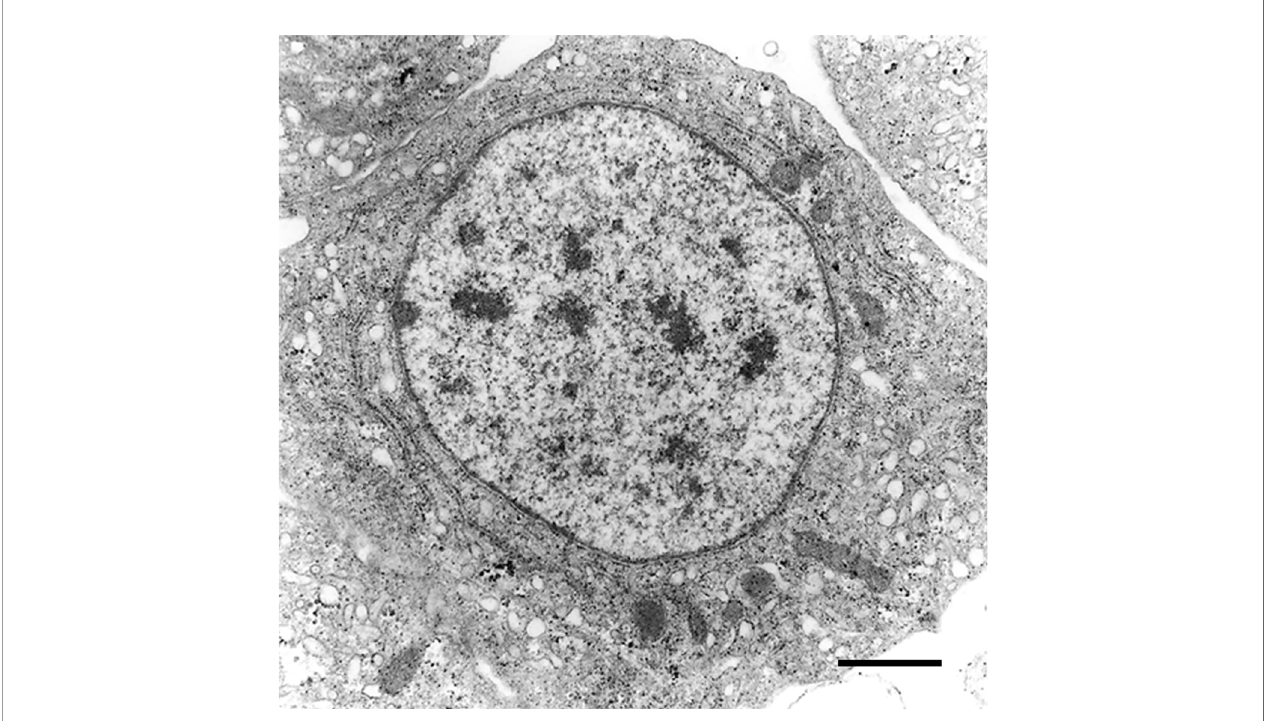
FIGURE 3 | A circulating agranulocyte of P. canaliculata with a round central nucleus, SER vesicles and RER cisternae, as well as some cytoplasmic granules (under TEM). Its ultrastructural features are compatible with the quiescent cells that have been described in the circulation (32). Scale bars represent 1 m m. Micrograph from (41).